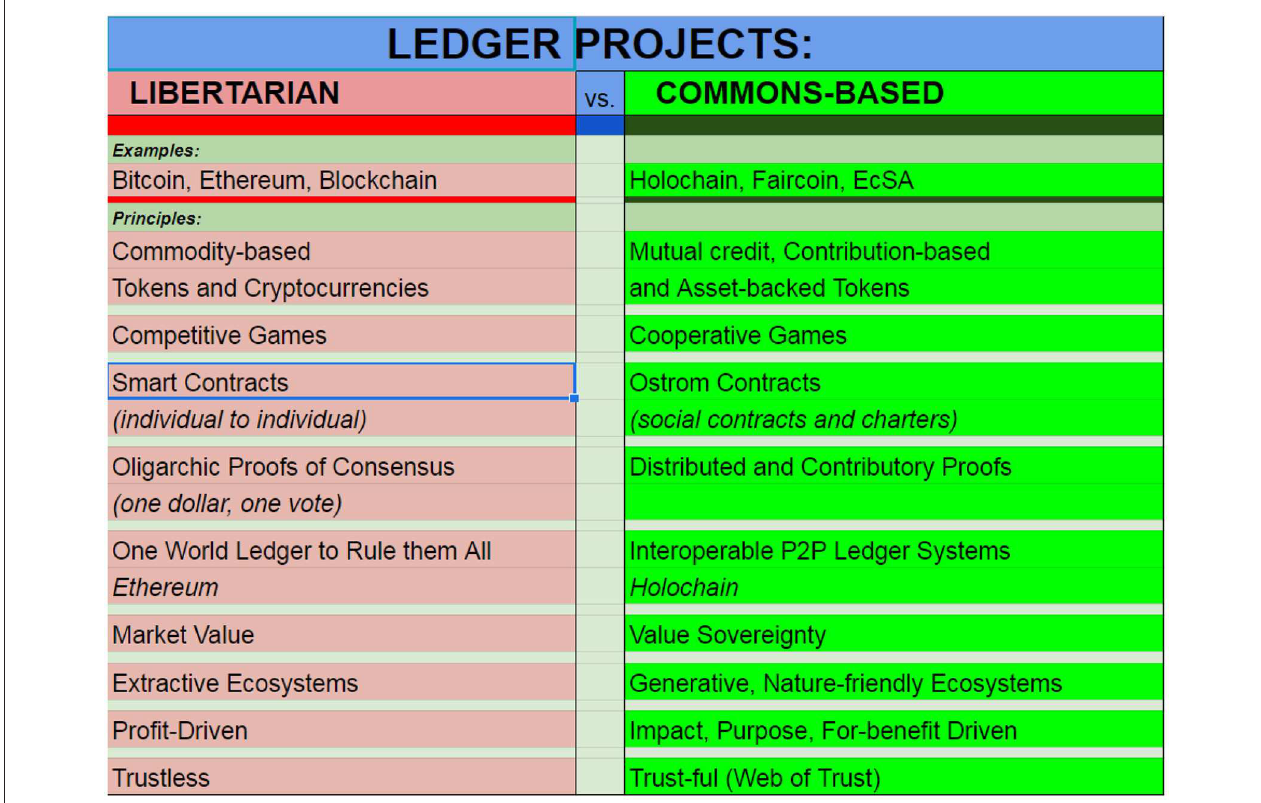
FIGURE 6 | A comparison of right-libertarian vs. commons-centric distributed ledgers (used with permission. Graphic by Michel Bauwens. Sourced from the report from P2P Foundation: P2P Accounting for Planetary Survival, 2019, https://wiki.p2pfoundation.net/P2P_Accounting_for_Planetary_Survival).